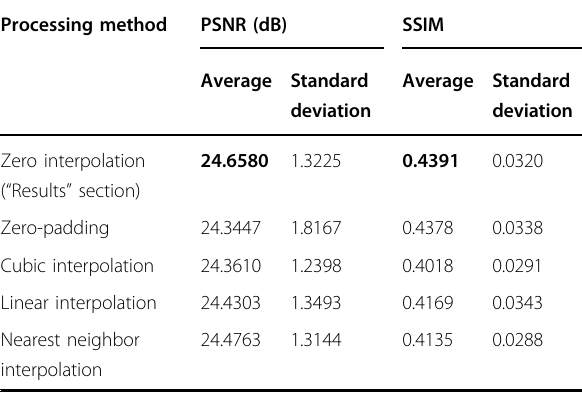
Table. 1 Comparison of PSNR and SSIM values between the network output images and the corresponding ground truth SS-OCT images for fi ve different pre-processing methods (also see Fig.